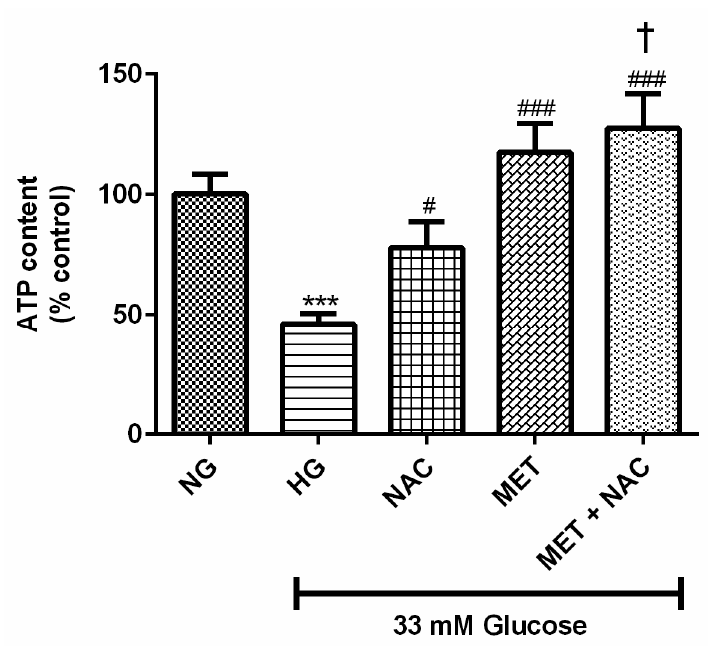
Figure 1. The combination effect of Metformin (MET) and N-acetylcysteine (NAC) on high glucose-induced metabolic activity. H9c2 cardiomyoblasts were cultured in high glucose (HG; 33 mM) for 24 h. Thereafter, cardiomyoblasts were treated with NAC (1 mM), metformin (MET) (1 µM) and a combination of MET + NAC. Cells treated with normal glucose (NG) served as the vehicle control. Data are presented as the mean ± SEM of 3 distinct biological experiments with each experiment having 3 technical repeats ( n = 9). Significance is depicted as *** p ≤ 0.001 versus NG control, # p < 0.05, ### p ≤ 0.001 versus HG control and † p < 0.05 versus NAC only.